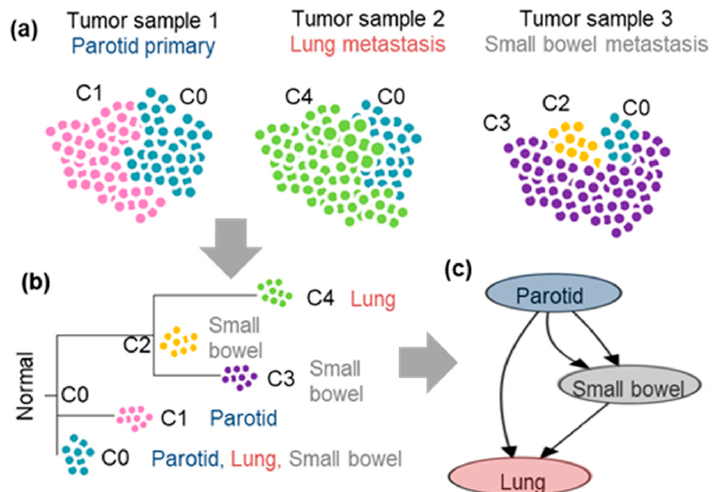
Figure 1. Inference of metastatic migration histories from a multi-sample bulk-sequencing dataset. ( a ) Patient ATP430 from Zhao et al. [6] was used. The data contained 5370 single-nucleotide variants. The primary tumor site was parotid. ( b ) CloneFinder [18] predicted clones C0–C4 (C0: blue, C1: pink, C2: yellow, C3: purple, C4: green). ( c ) Given CloneFinder clone phylogeny, PathFinder [9] inferred a metastatic migration map.